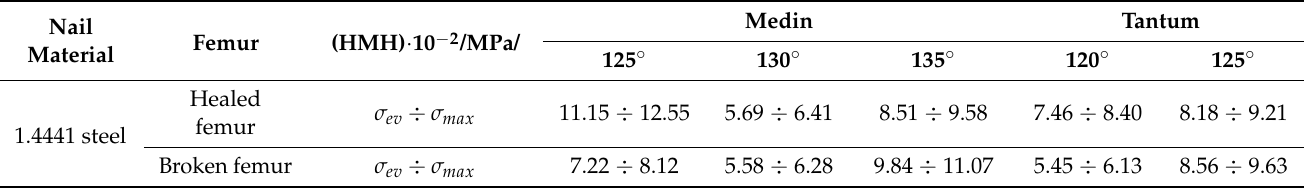
Table 5. Stress values at F = 1 N results in 10 − 2